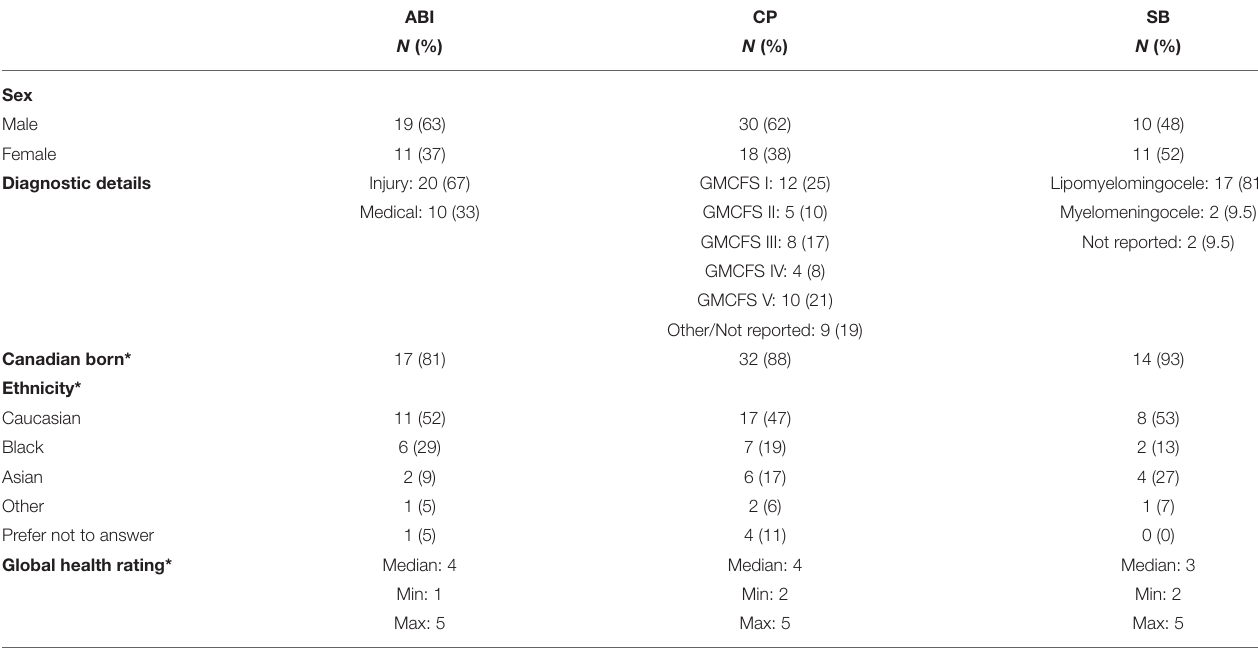
TABLE 1 | Clinical and demographic characteristics of (prospective) participants at study enrolment (16 years of age).